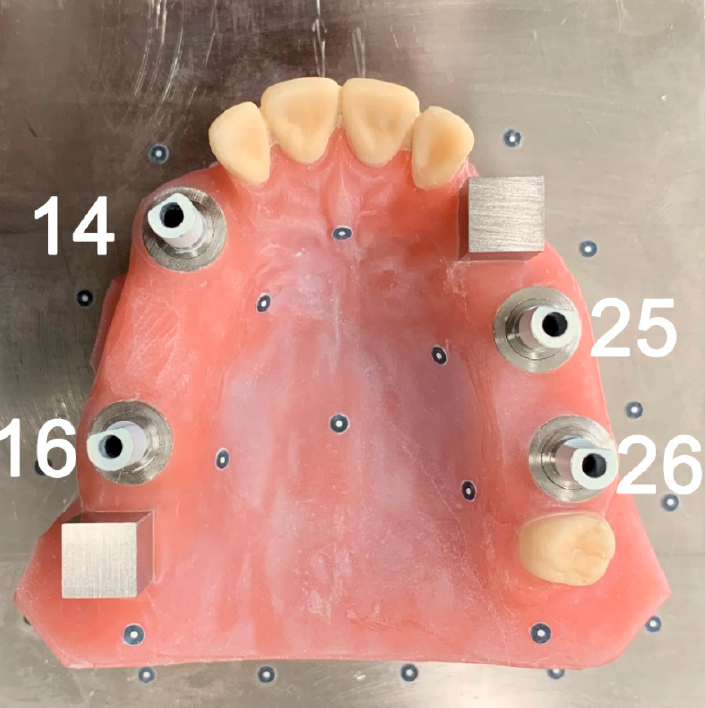
Figure 1. Implant master model (IMM) with two reference cubes and final setup with inserted scan bodies (FDI 16, 14, 25, 26).